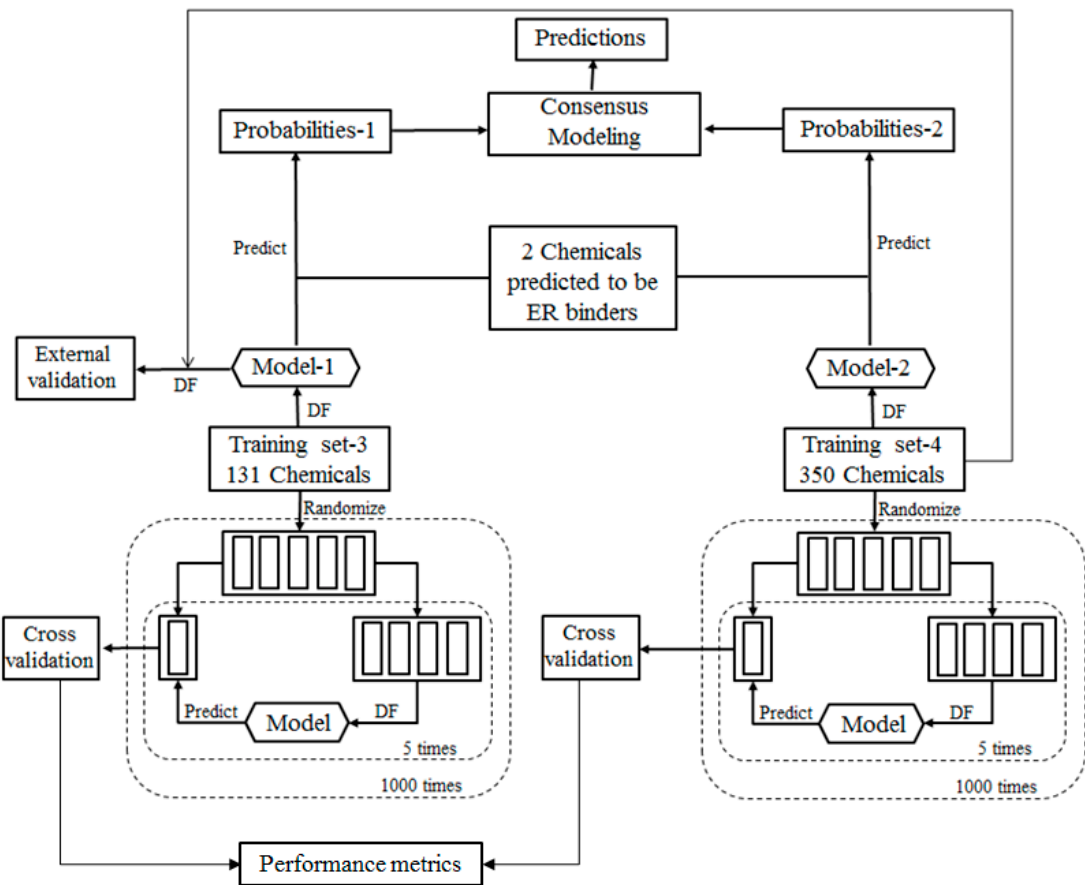
Figure 3. Workflow of the consensus regression modeling for estimating ER binding affinity of sunscreen ingredients.